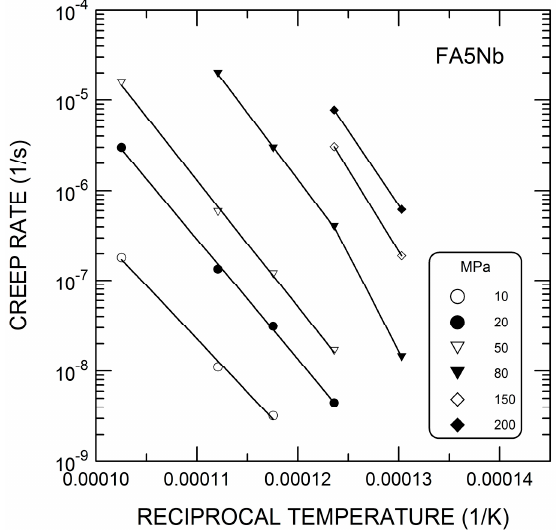
Figure 7. Dependence of minimum creep rate on reciprocal temperature for the alloy FA5Nb.